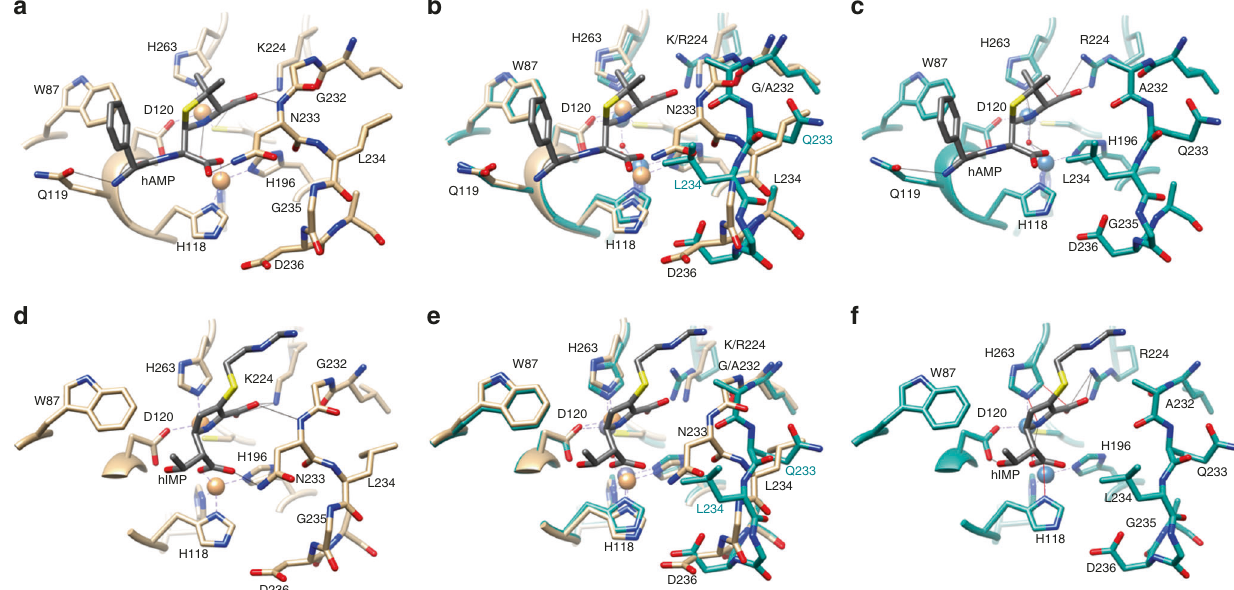
Fig. 7 Structural alignments of the NDM-1 triple mutant with NDM-1/product complexes. a Structure of wild-type NDM-1 (tan) in complex with hydrolyzed ampicillin (3Q6X). Hydrolyzed ampicillin is shown in gray. Hydrogen bonds are indicated by thin black lines. b Structural alignment of wild-type NDM-1 (tan) with hydrolyzed ampicillin (gray) and the NDM-1 triple mutant (dark cyan). Hydrogen bonds are not shown for clarity. c Structural alignment from panel ( b ) with the wild-type NDM-1 structure removed but leaving the hydrolyzed ampicillin from the wild-type structure in place. d Structure of wild-type NDM-1 (tan) in complex with hydrolyzed imipenem (5YPI 7 ). Hydrolyzed imipenem is shown in gray. e Structural alignment of wild-type NDM-1 (tan) with hydrolyzed imipenem (gray) and the NDM-1 triple mutant (dark cyan). Hydrogen bonds are not shown for clarity. f Structural alignment from panel ( e ) with the wild-type NDM-1 structure removed but leaving the hydrolyzed imipenem from the wild-type structure in place. Thin black lines indicate hydrogen bonds. Thin red lines indicate close contacts with steric